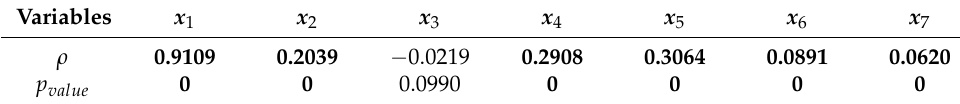
Table 4. Input variables selected based on Spearman’s